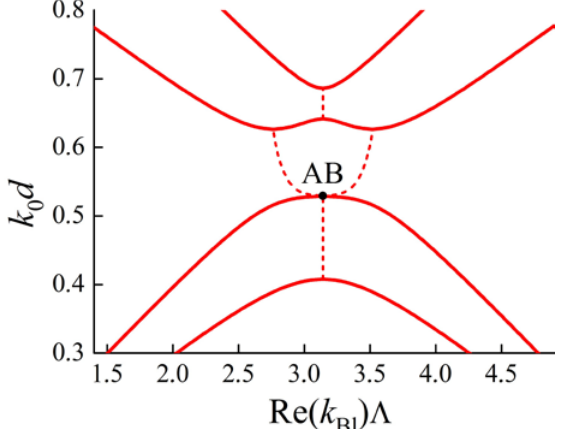
Figure 9. Frequency dependence of all layers, 2 d Λ = is a PC period). The solid lines correspond to propagating waves, the dashed lines correspond to